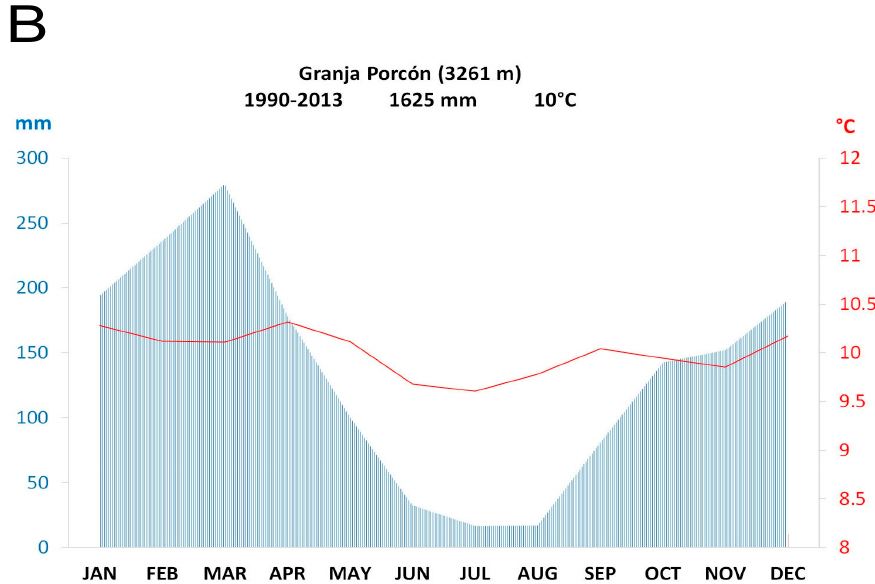
Figure 1. ( A ) Location of Cushuro’s unthinned area and Enterador’s thinned area and ( B ) climate variability (1990–2013) [39].